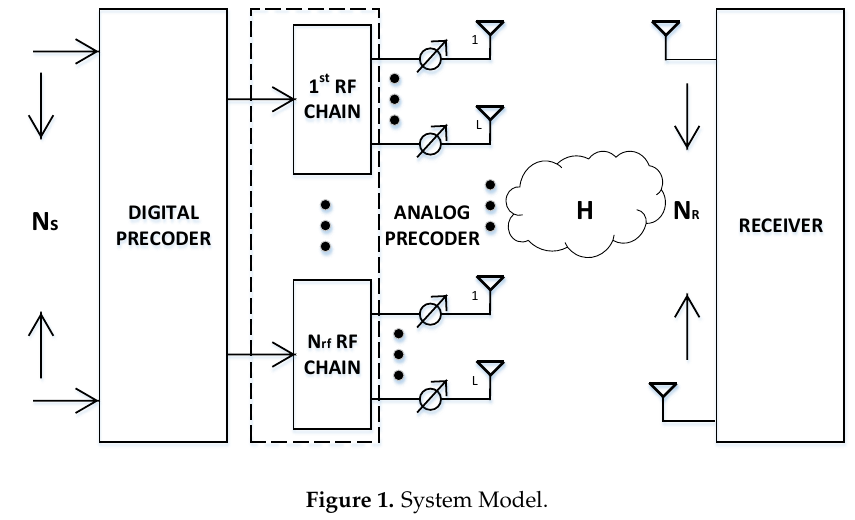
Figure 1. System